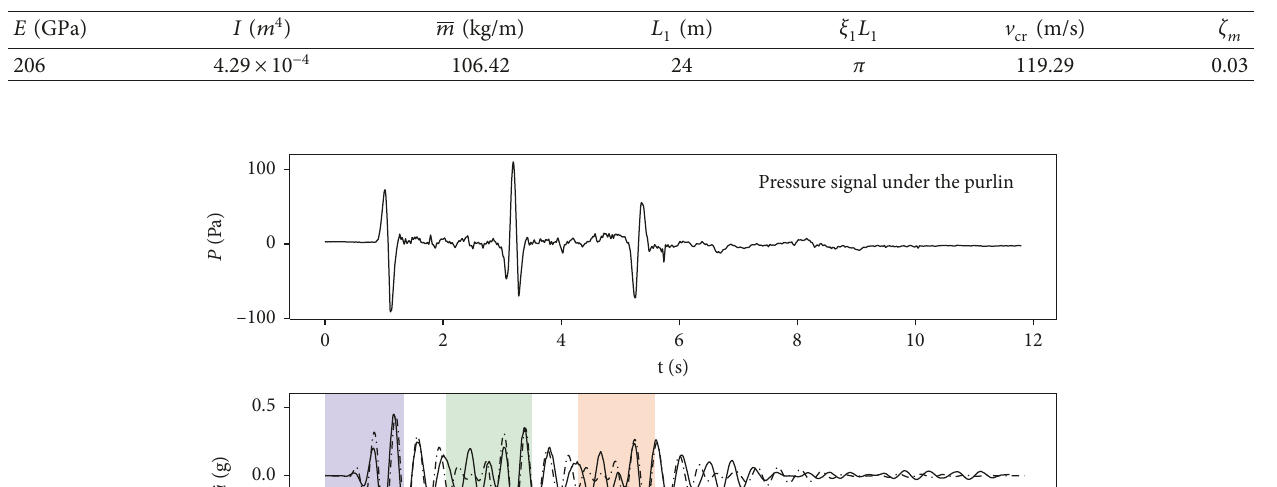
Table 1: Parameters of the purlin.